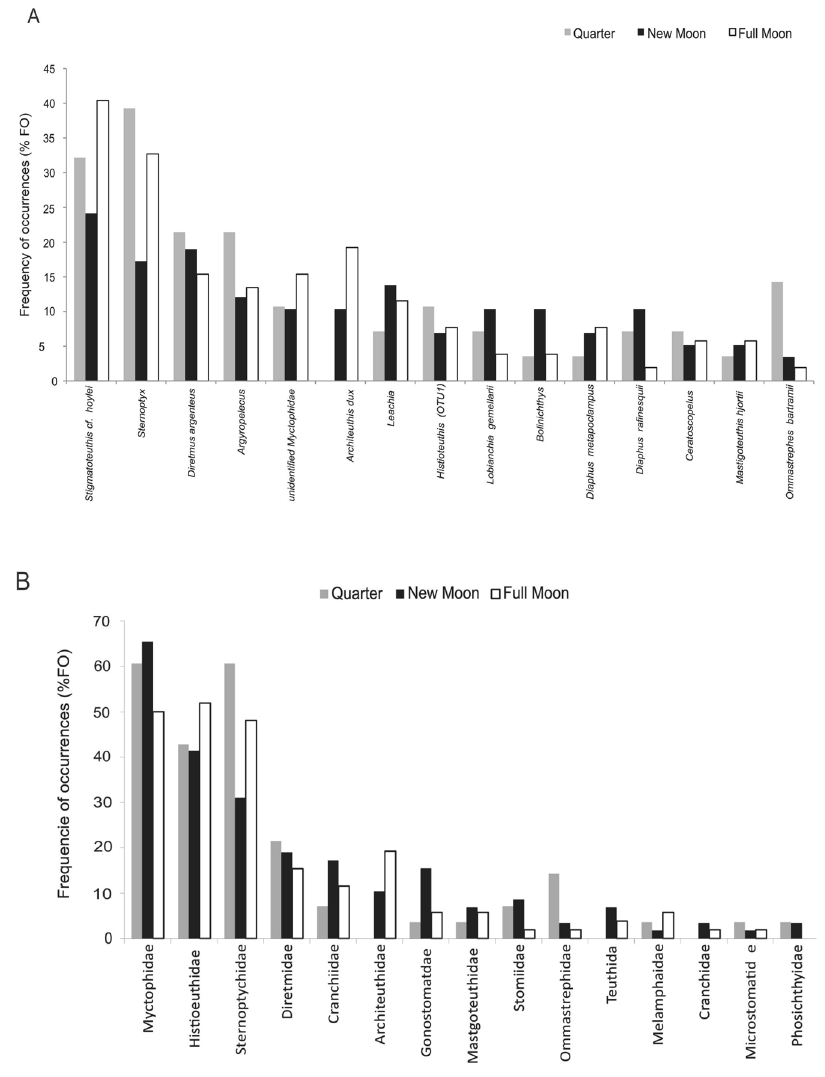
Figure 1. Frequency of occurrence of the taxa identified in Bulwer’s petrels stomach-contents at different lunar phases (full moon = 52, new moon = 58, quarter moon = 28); expressed as presence of a specific prey type against total number of stomach-contents collected in each lunar phase. ( A ) Prey identified to the lowest taxonomical rank. ( B ) Prey pooled into family ranks. Only the taxa occurring in over 5% of the total number of stomach contents are